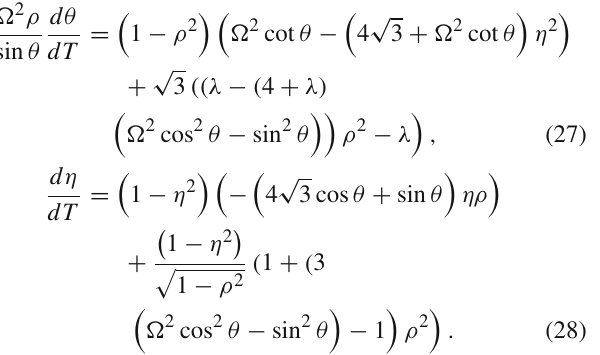
are attractors and the Kantowski–Sachs solutions are 3